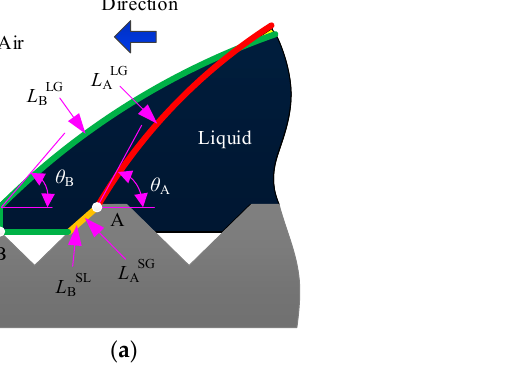
Similarly, the free energy change → Δ from point B to point C can be expressed as: